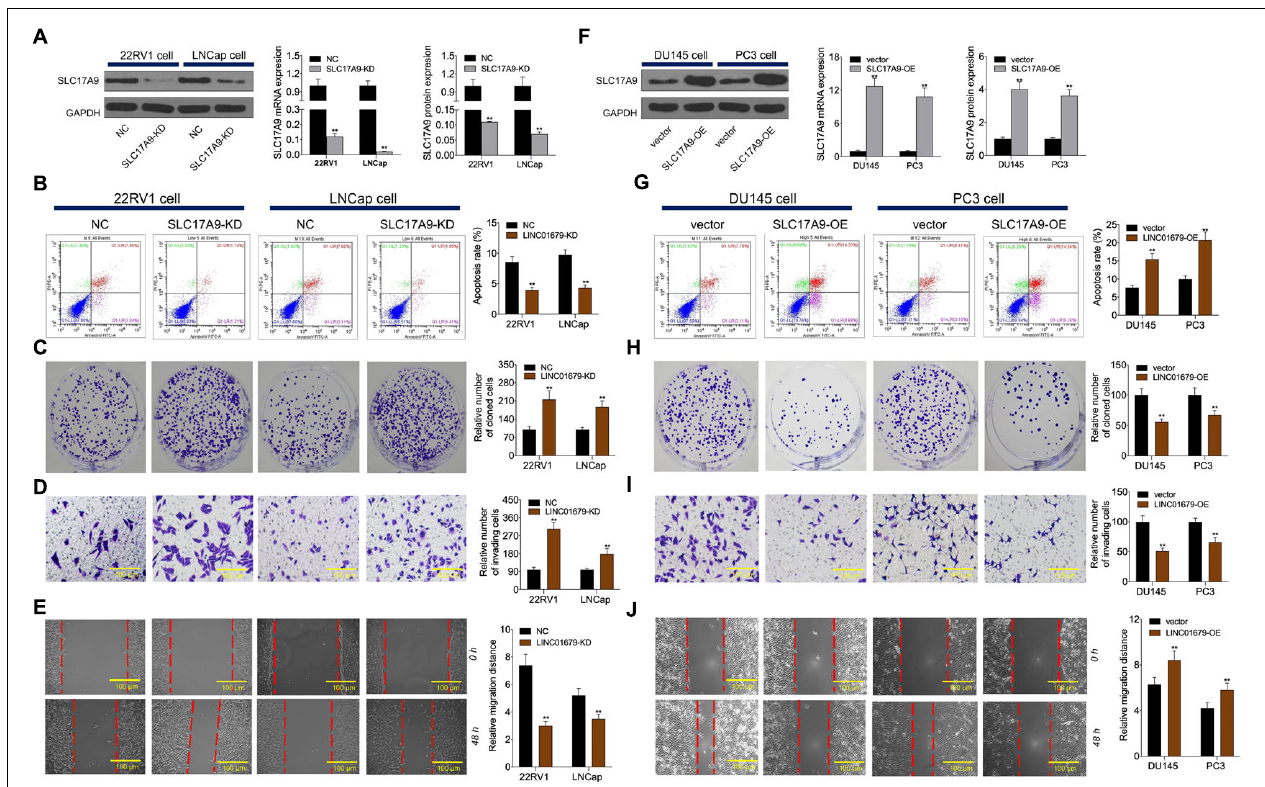
FIGURE 8 | SLC17A9 regulated cell proliferation, apoptosis, migration, and invasion in vitro . SLC17A9 expression (A,F) , cell apoptosis (B,G) , proliferation (C,H) , invasion (D,I) , and migration (E,J) of cells transfected with siRNA-SLC17A9 or SLC17A9-expressing vector determined by qRT-PCR, WB, flow cytometry, colony formation, Transwell, and scratch assays. The experiment was repeated thrice independently; ** vs. NC or vector group, p <